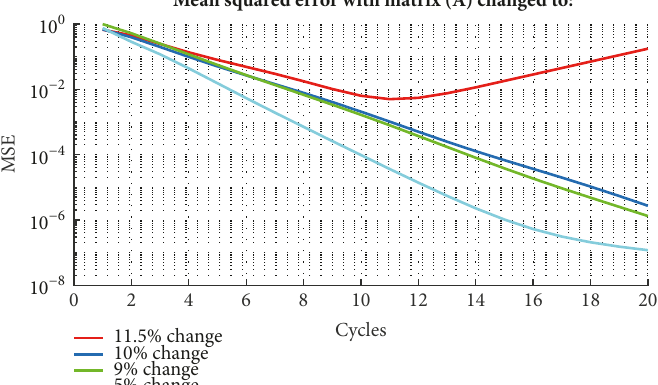
Figure 9: Mean squared error for the NMP output with dynamic matrix ( 𝐴 ) variations and 𝑤𝑓